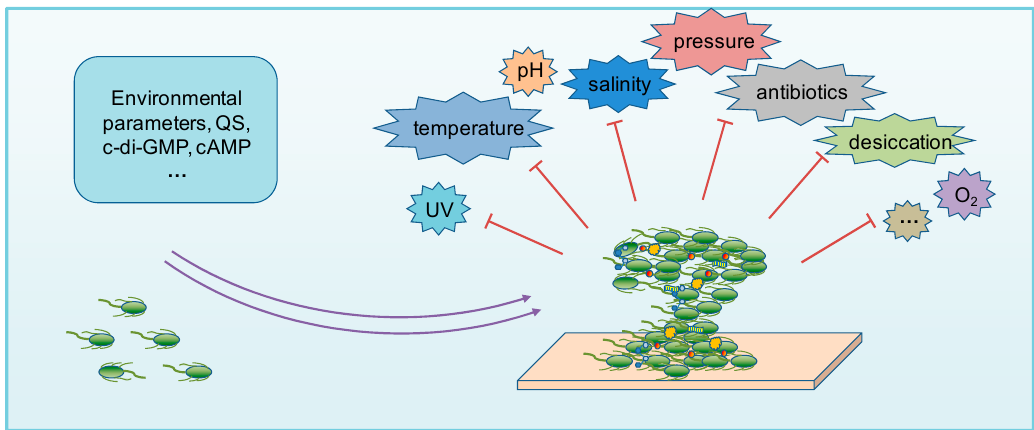
Figure 2. A schematic representation of the biofilm function. Biofilm formation can increase the resistances of microorganisms to various extreme environments.